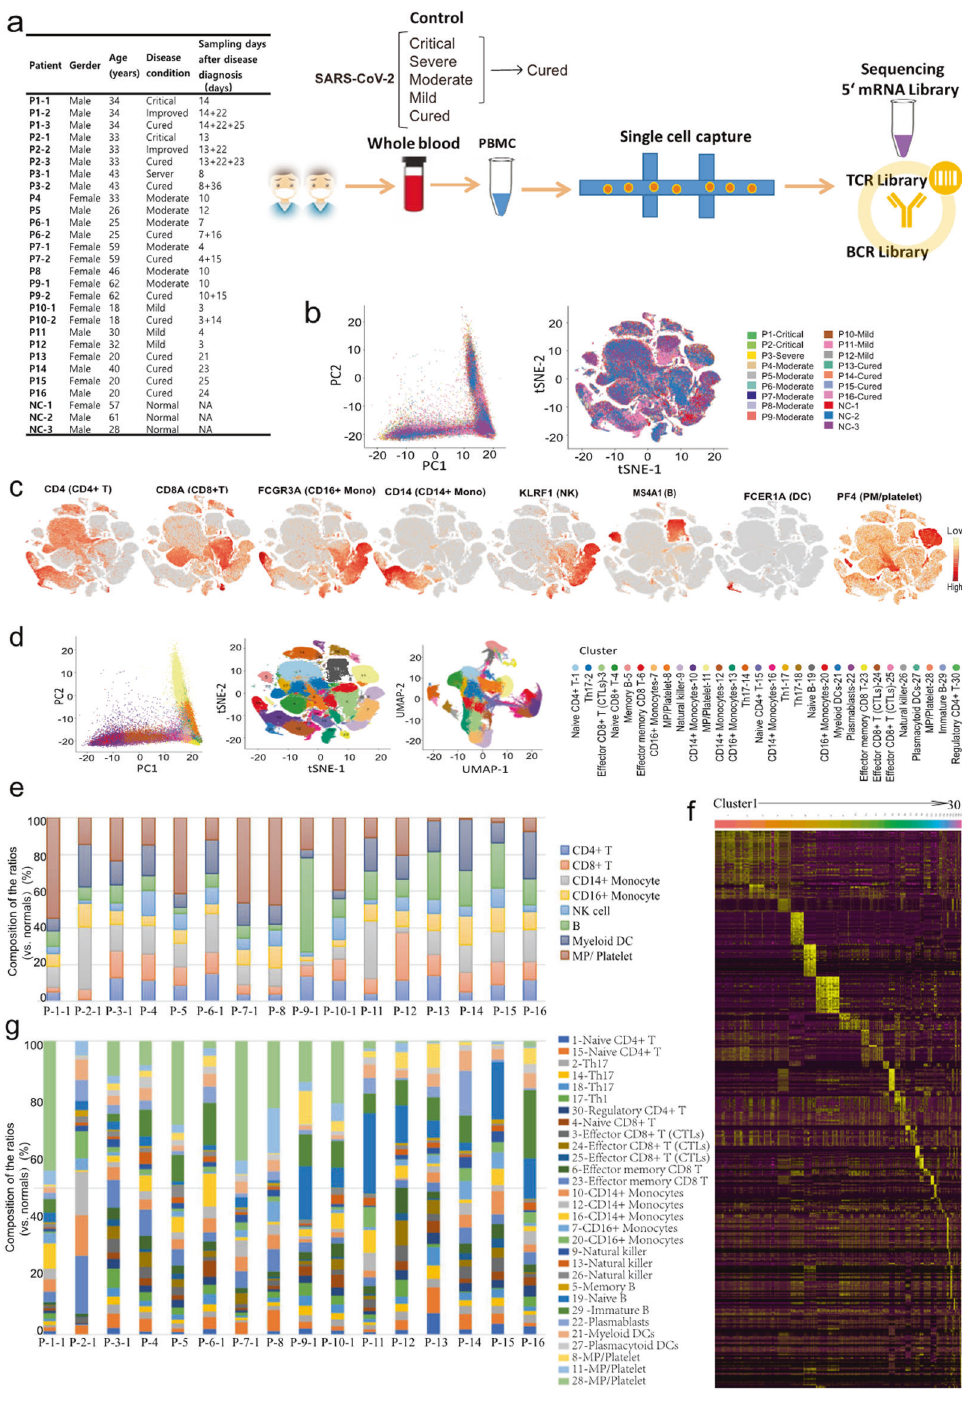
Fig. 1 Cellular composition of the PBMCs in patients with COVID-19 and controls. a Brief summary of the samples for scRNA sequencing and the study design. The detailed information of the samples is shown in Table S1. b Integration analysis results of patients with COVID-19 and normal controls showing principal component (PC) and TSNE algorithm visualization. No beach effect was observed between the samples. c Eight main PBMC cell types identi fi ed by known cell markers. d Integration analysis results of patients with COVID-19 and normal controls showing principal component (PC), TSNE algorithm, and UMAP algorithm visualization. In total, 30 cell subtypes were identi fi ed in PBMC. e Composition of the ratios of the main cell type compositions of PBMC comparing each of the patients to normal controls. The proportion of each cell type in each sample was calculated and then compare the proportion of each cell type between cases and controls (for control samples, the mean proportion of three control samples was used for comparing). f The gene expression heatmap of the top 30 genes for each cell subtype. g Composition of the ratios of all the 30 cell subtype compositions of PBMC comparing each patient to normal controls. The proportion of each cell subtype in each sample was calculated and then compare the proportion of each cell subtype between cases and controls (for control samples, the mean proportion of three control samples was used for comparing)